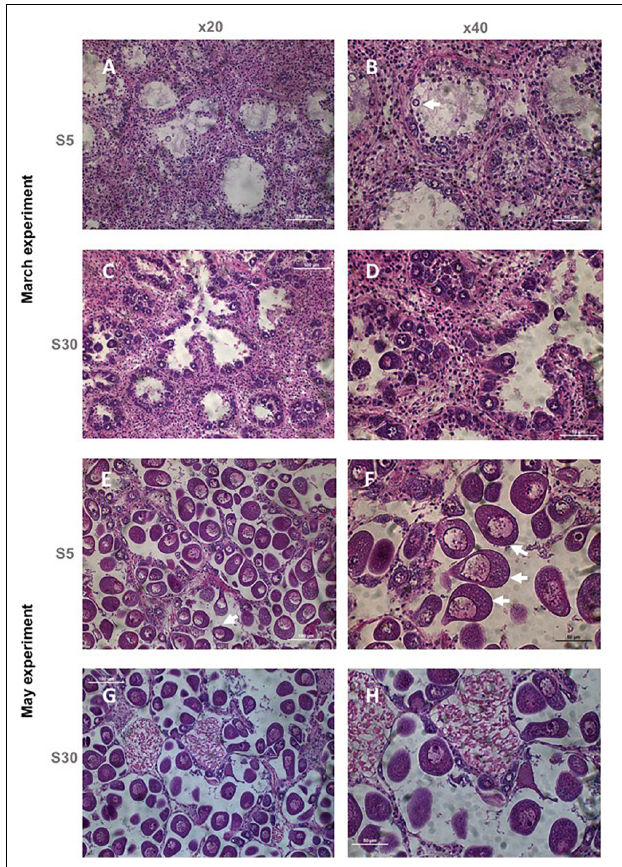
FIGURE 6 | Photomicrographs showing gametogenic stages in female of Ruditapes decussatus . (A) March experiment at salinity treatment S5: female in early gametogenesis ( × 20). (B) March experiment at salinity treatment S5: female in early gametogenesis ( × 40). (C) March experiment at salinity control S30: female in early gametogenesis ( × 20). (D) March experiment at salinity control S30: female in early gametogenesis ( × 40). (E) May experiment at salinity treatment S5: mature female ( × 20). (F) May experiment at salinity treatment S5: mature female ( × 40). (G) May experiment at salinity control S30: mature female ( × 20). (H) May experiment at salinity control S30: mature female ( × 40). White arrows indicate examples of abnormal